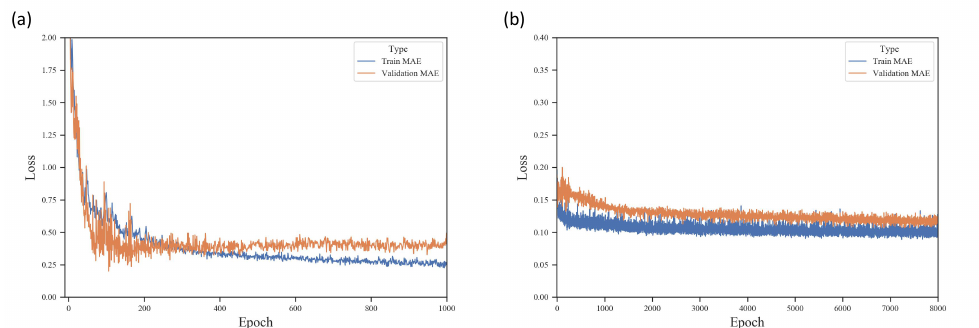
Figure 4. Convergence plot of the ( a ) F-GCN model on experimental NMR 1 H chemical shifts predictions and ( b ) difference NMR 1 H chemical shifts